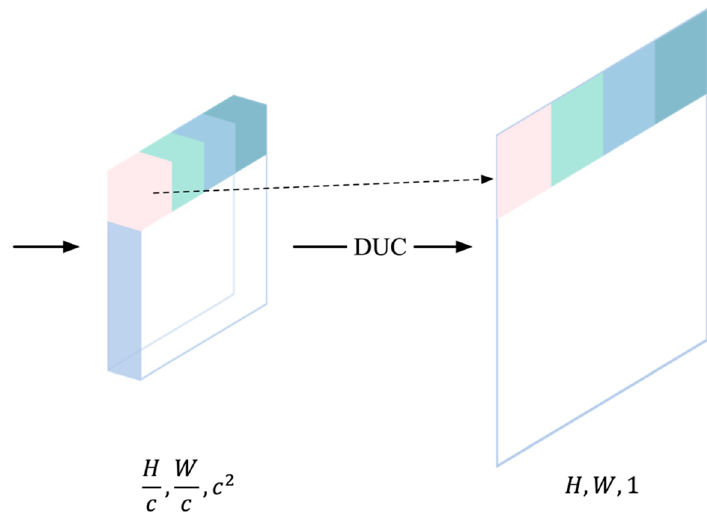
Figure 5. Densly upsampling convolution (DUC).